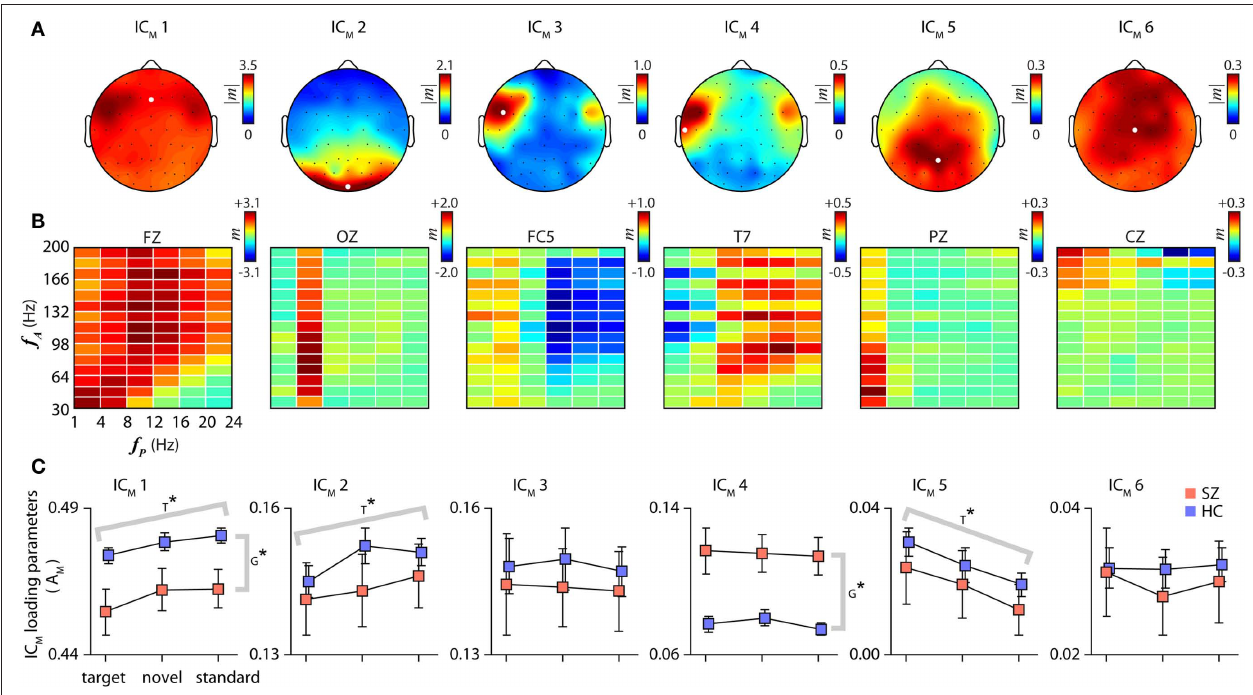
between components; components are listed in decreasing order of their variance. (C) Component loading parameters for each condition stratified by SZ (red) and HC (blue) groups (REL subjects not shown). Error bars in this and all subsequent plots denote ± 1 SEM. T* and G* indicate significant differences over conditions or groups, respectively, as determined with a repeated measures one-way ANOVA ( P < 0.05, Bonferroni corrected for